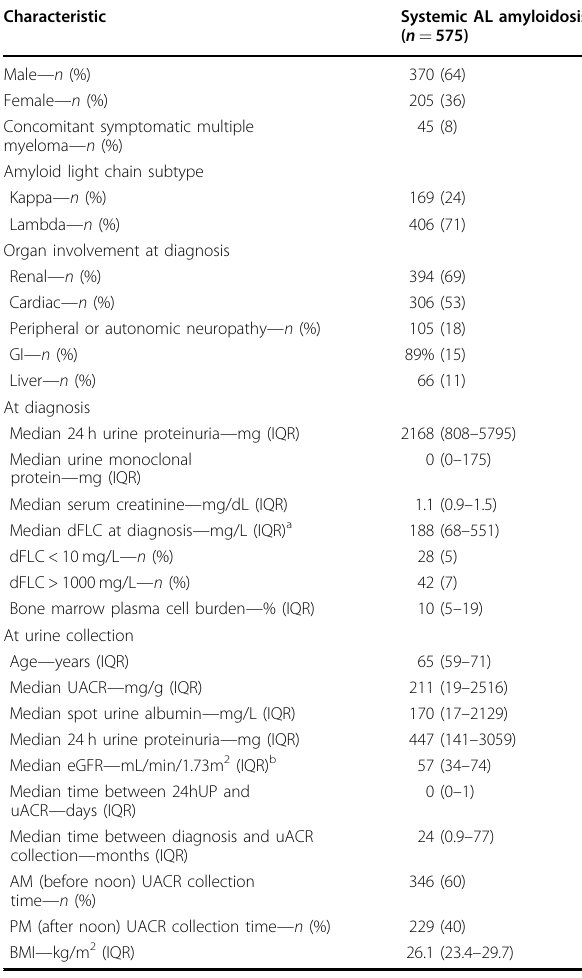
Table 1 Baseline characteristics of systemic AL amyloidosis